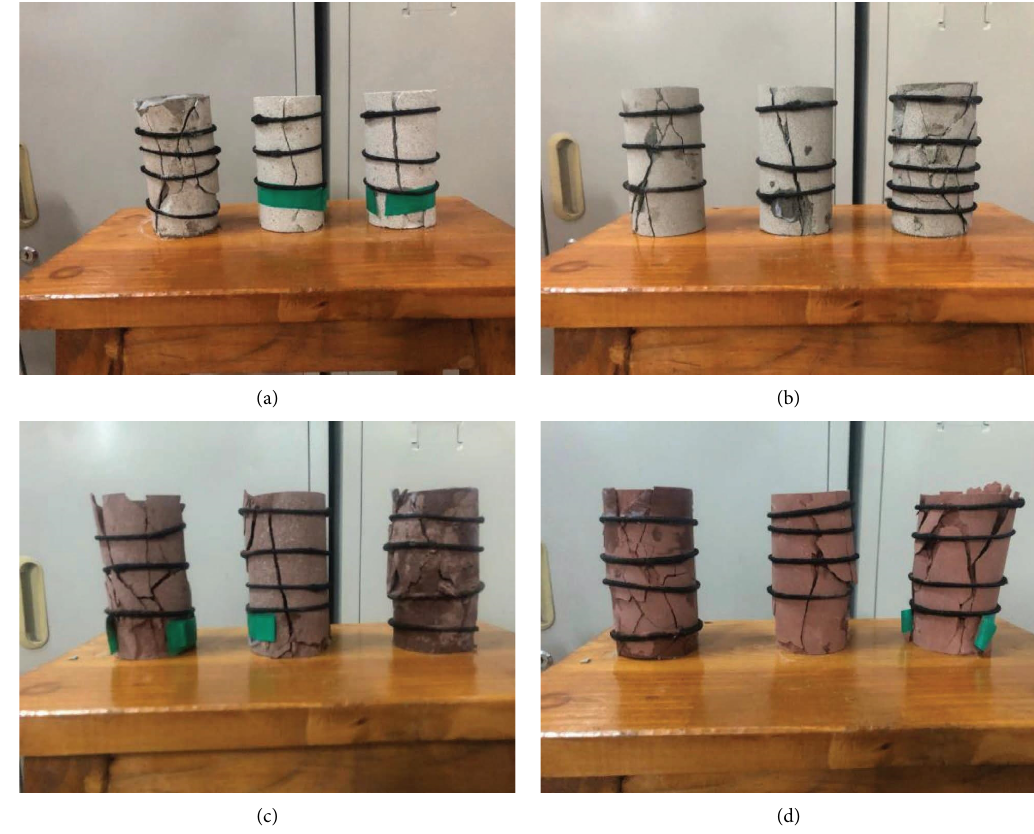
Figure 8: Failure characteristics of sandstone samples with different particle sizes. (a) QSY